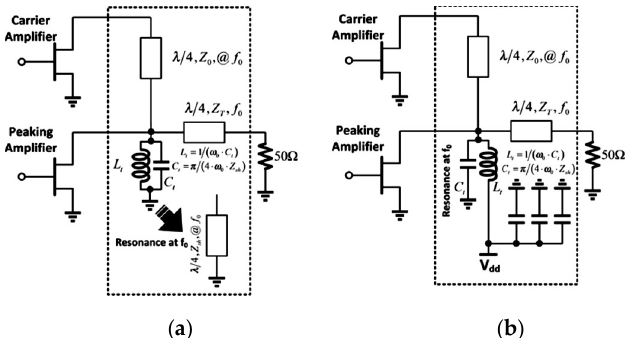
Figure 16. The broadband output combiner employs a resonance LC tank at the output of the peaking PA ( a ) The short-circuited, quarter-wave stub as a resonator can be approximated by a parallel LC tank [93]. ( b ) The tank inductor Lt can act as the biasing feed for both the carrier and peaking amplifiers [94].